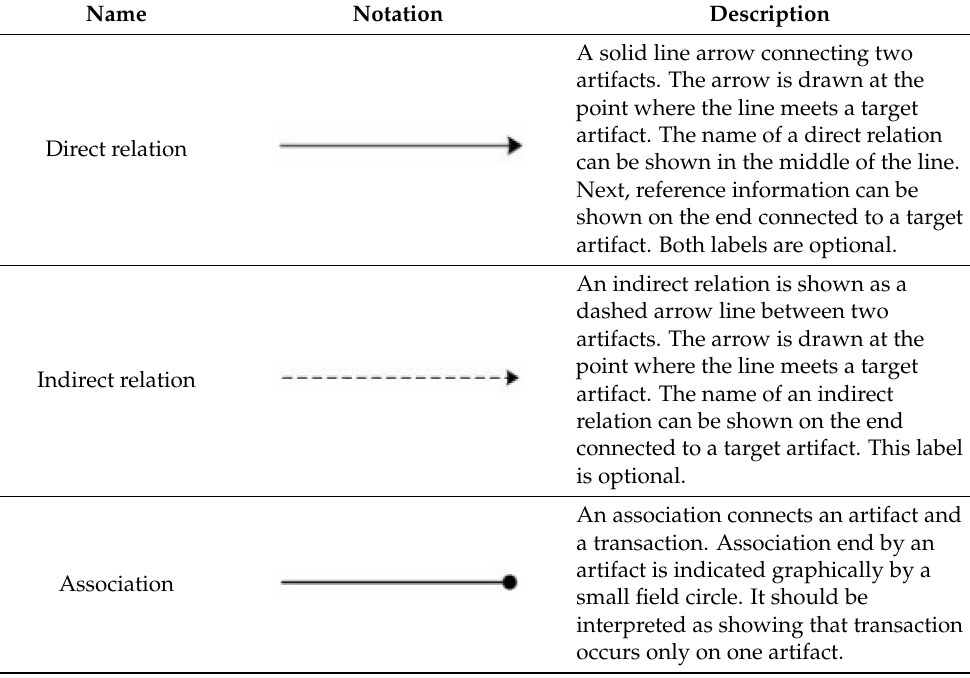
Table 2. Connector elements of the domain-specific modeling